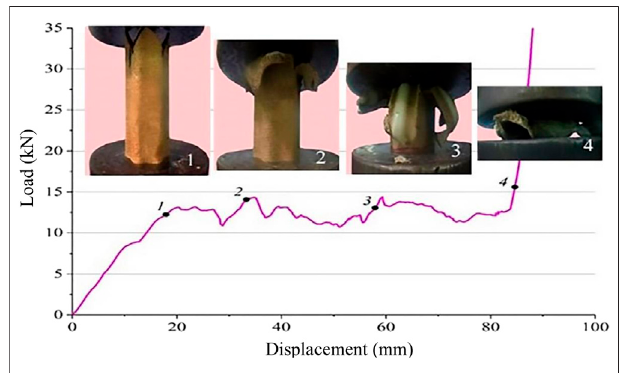
FIGURE 3 | Representative load vs. displacement and collapse history of corrugated JCS with three